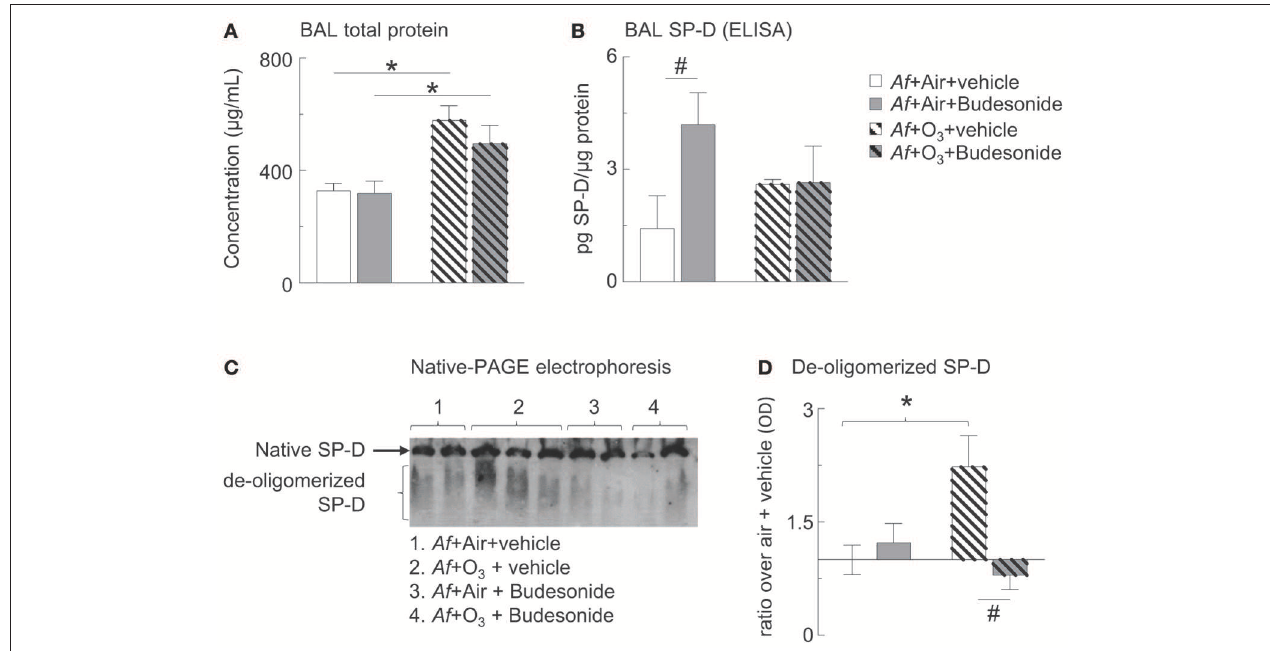
FIGURE 5 | O 3 inhibited budesonide-induced SP-D expression in Af -challenged mice and caused SP-D de-oligomerization in the BAL. (A) Cell-free BAL supernatant was assessed for total protein by BCA assay. (B) BAL SP-D was measured by ELISA. (C) Native-PAGE western blot was used to study SP-D structure. Native (intact) SP-D is the band that due to its molecular size remain on the top of the gel. Due to the variability of migratory capabilities of the de-oligomerized SP-D components, these appear as a “smear” throughout the gel. (D) SP-D optical density by Image J analysis; ratio over the mean value of “air + vehicle” control group data. Mean ±